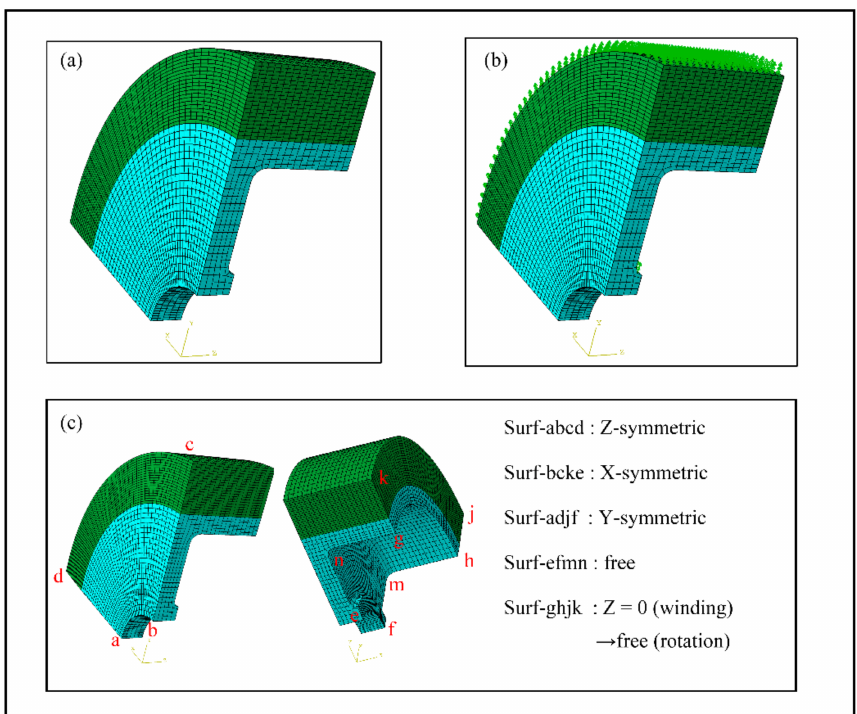
Figure 7. Modeling of flywheel rotor: ( a ) meshing ( b ); centrifugal load; and ( c ) boundary conditions.